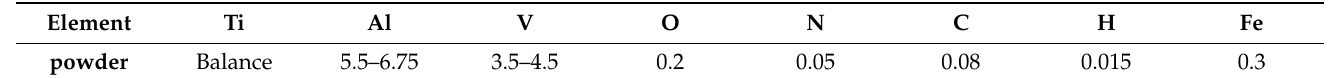
Table 2. Nominal chemical compositions of gas-atomized powder material of Ti6Al4V alloy (wt%).